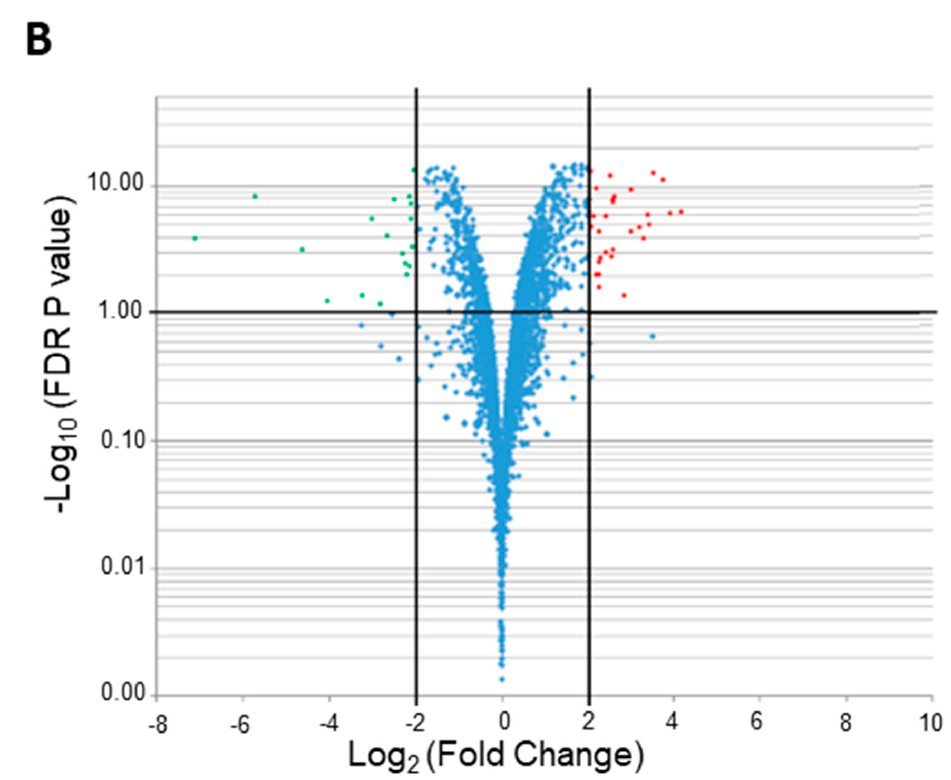
Figure 1. Identification of differentially expressed genes (DEGs). ( A ) MA plot showing the relation- ship between gene expression level (A values on the x axis) and fold-change (FC) (M values on the y axis) across genes. The discontinuous horizontal black lines indicate the fold-change (FC) threshold applied (absolute value of log 2 FC ≥ 2). DEGs displaying statistical significance (i.e., meeting this FC criterion) are shown as red (176 upregulated genes) or green (104 downregulated genes) dots. ( B ) Volcano plot displaying FC plotted against the false discovery rate (FDR) p -value. The y axis represents the − log 10 FDR p -value and the x axis represents the log 2 FC value. The horizontal black line indicates the significance threshold ( − log 10 p -value ≥ 1), and the vertical black lines indicate the FC threshold (absolute value of log 2 FC ≥ 2). DEGs displaying statistical significance (i.e., those meeting both criteria) are shown as 105 upregulated (red dots) and 71 downregulated (green dots) genes in the right-upper and left-upper areas of the panel delineated by black lines, respectively.